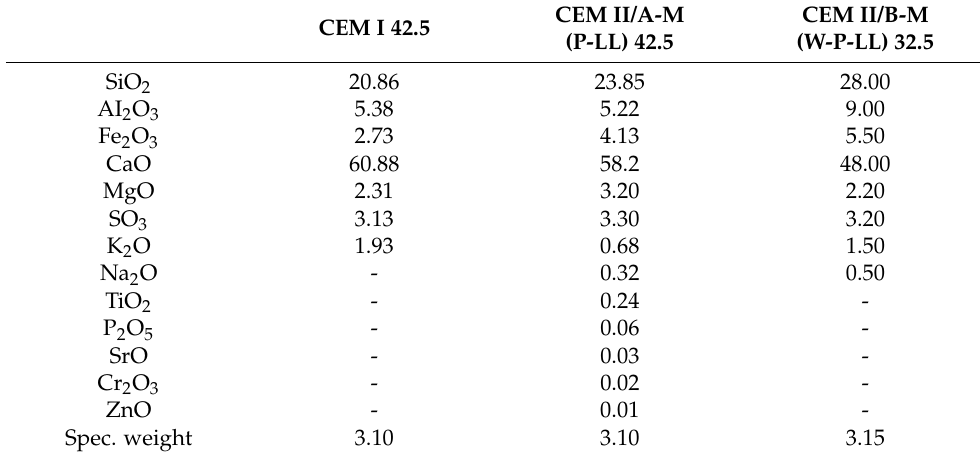
4 Table 1. Chemical analysis and specific weight of cements. CEM I 42.5